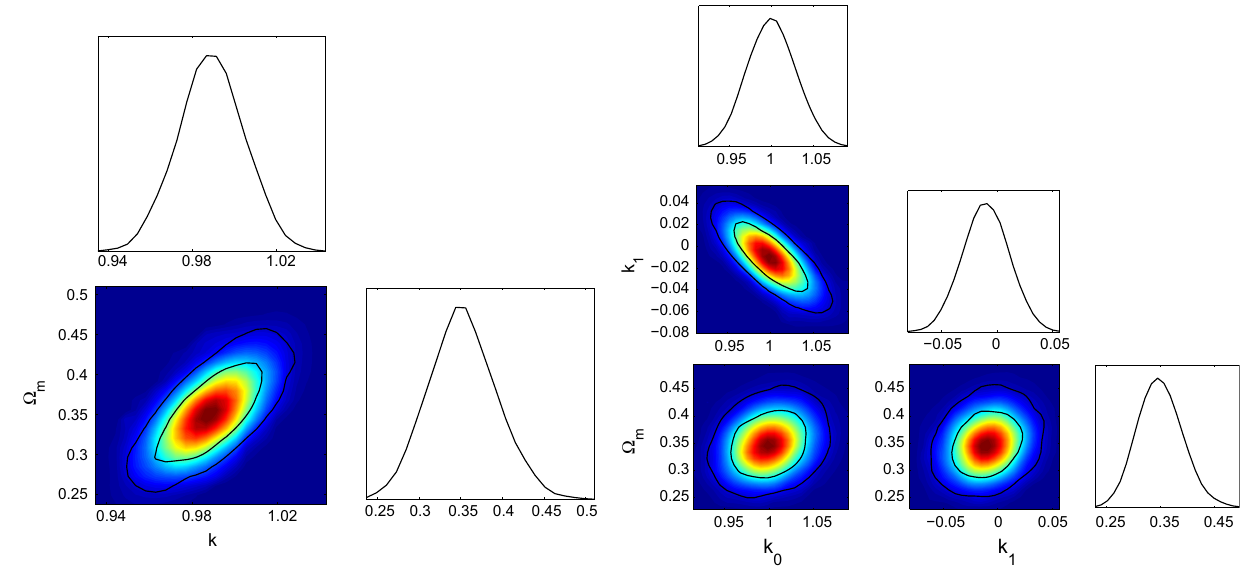
Fig. 3 Normalized posterior likelihood of (cid:2) m in the flat (cid:3) CDM model, which is derived from multi-frequency P15